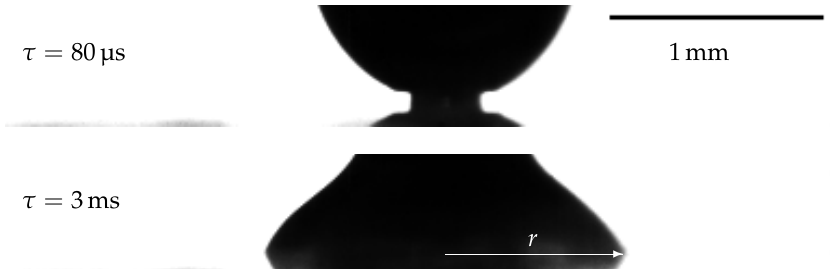
Figure 2. Two images of wetting experiments at the initial stage. The reflection of the actual droplet shadow can be observed at the bottom region of the pictures due to the camera alignment. Toluene on PS ( M W = 320kgmol − 1